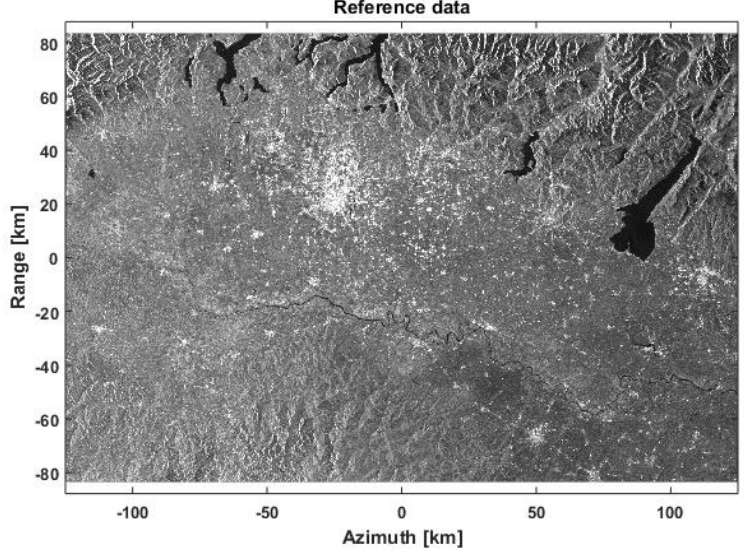
Figure 21. Simulated reference focused GEO SAR image. The target decorrelation effect is not included.